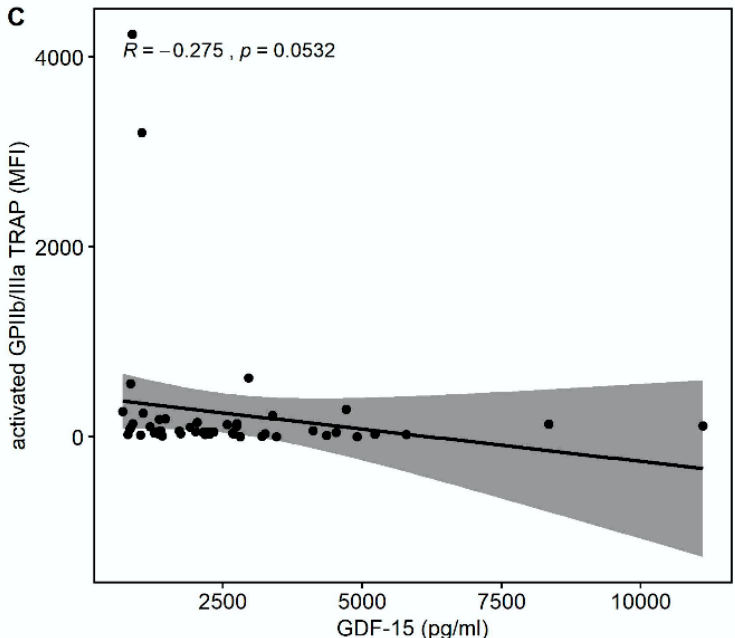
Figure 2. Correlations of GDF-15 with the platelet surface expression of activated glycoprotein (GP) IIb/IIIa. ( A ) Scatter plot showing GDF-15 ( x -axis) versus activated GPIIb/IIIa in response to arachidonic acid (AA) ( y -axis). ( B ) Scatter plot showing GDF-15 ( x -axis) versus activated GPIIb/IIIa in response to adenosine diphosphate (ADP) ( y -axis). ( C ) Scatter plot showing GDF-15 ( x -axis) versus activated GPIIb/IIIa in response to thrombin receptor-activating peptide (TRAP) ( y -axis). Median multiple electrode aggregation (MEA) AA was 20 AU (IQR 14–28), median MEA ADP was 60 AU (IQR 48–74), and median MEA TRAP was 98 AU (IQR 67–114). GDF-15 correlated inversely with MEA TRAP (r = − 0.326, p = 0.0194), whereas the correlation of GDF-15 with MEA ADP (r = − 0.235, p = 0.0968) and MEA AA (r = − 0.148, p = 0.2998) did not reach statistical significance (Figure 3). GDF-15 did not correlate with soluble P-selectin (r = − 0.062, p = 0.626).